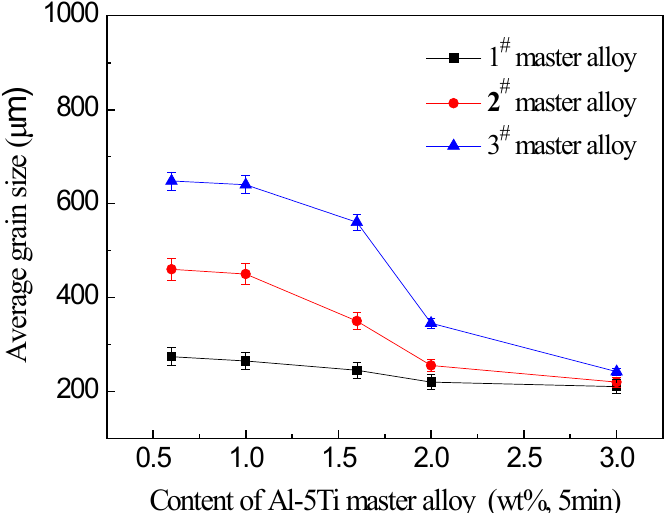
Figure 10. The relation curve between the content of Al–5Ti master alloy and the average size of solidified commercial pure aluminum samples.